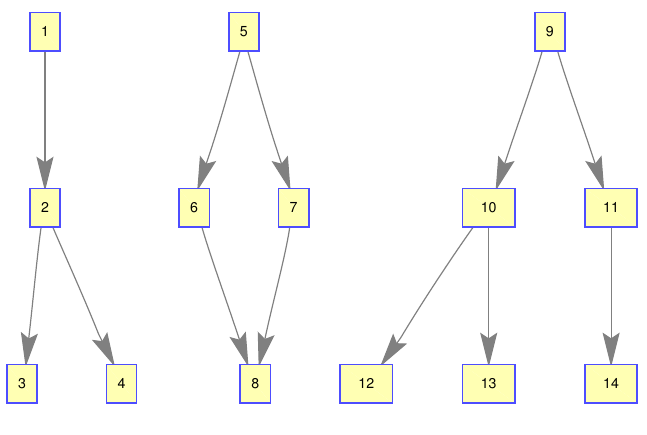
Figure 5. The structure of subgroup